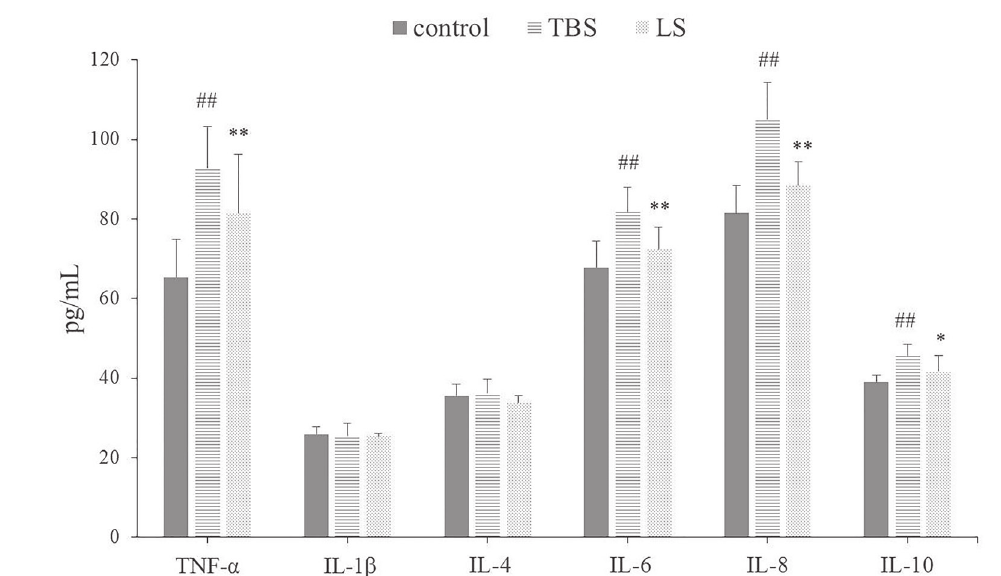
FIGURE 2 - The levels of TNF-α, IL-1β, IL-4, IL-6, IL-8, and IL-10 from rat urine (pg/mL). Data shown are mean ± SD (n = 10 per group). ## p < 0.01 vs control group, ** p < 0.01 and * p < 0.05 vs TBS group.